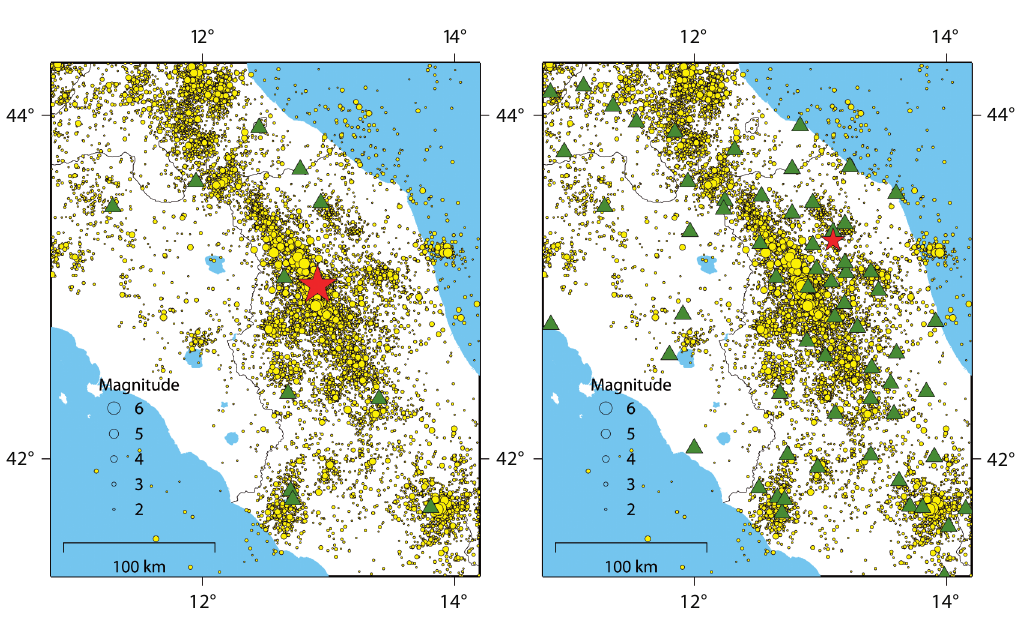
Fig. 10. Comparison between network geometries for the Mw5.8, 1997 Umbria-Marche main shock, and a ML3.1 earthquake that occurred in 2007. The seismic stations are the green triangles, the yellow dots are the 1981-2002 seismicity of the CSI catalogue. The network for the 2007 event includes the RSN and the Marche regional